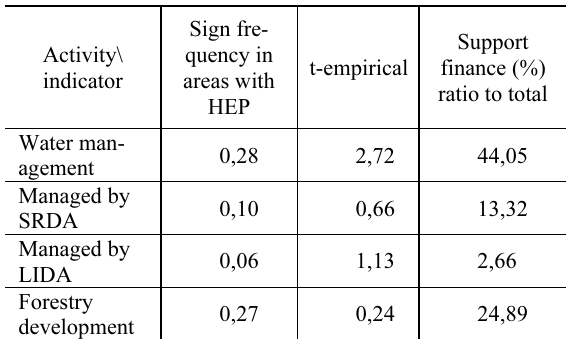
Table 14. Results of different EU structural fund distribution for municipalities of areas with high environmental protection levels